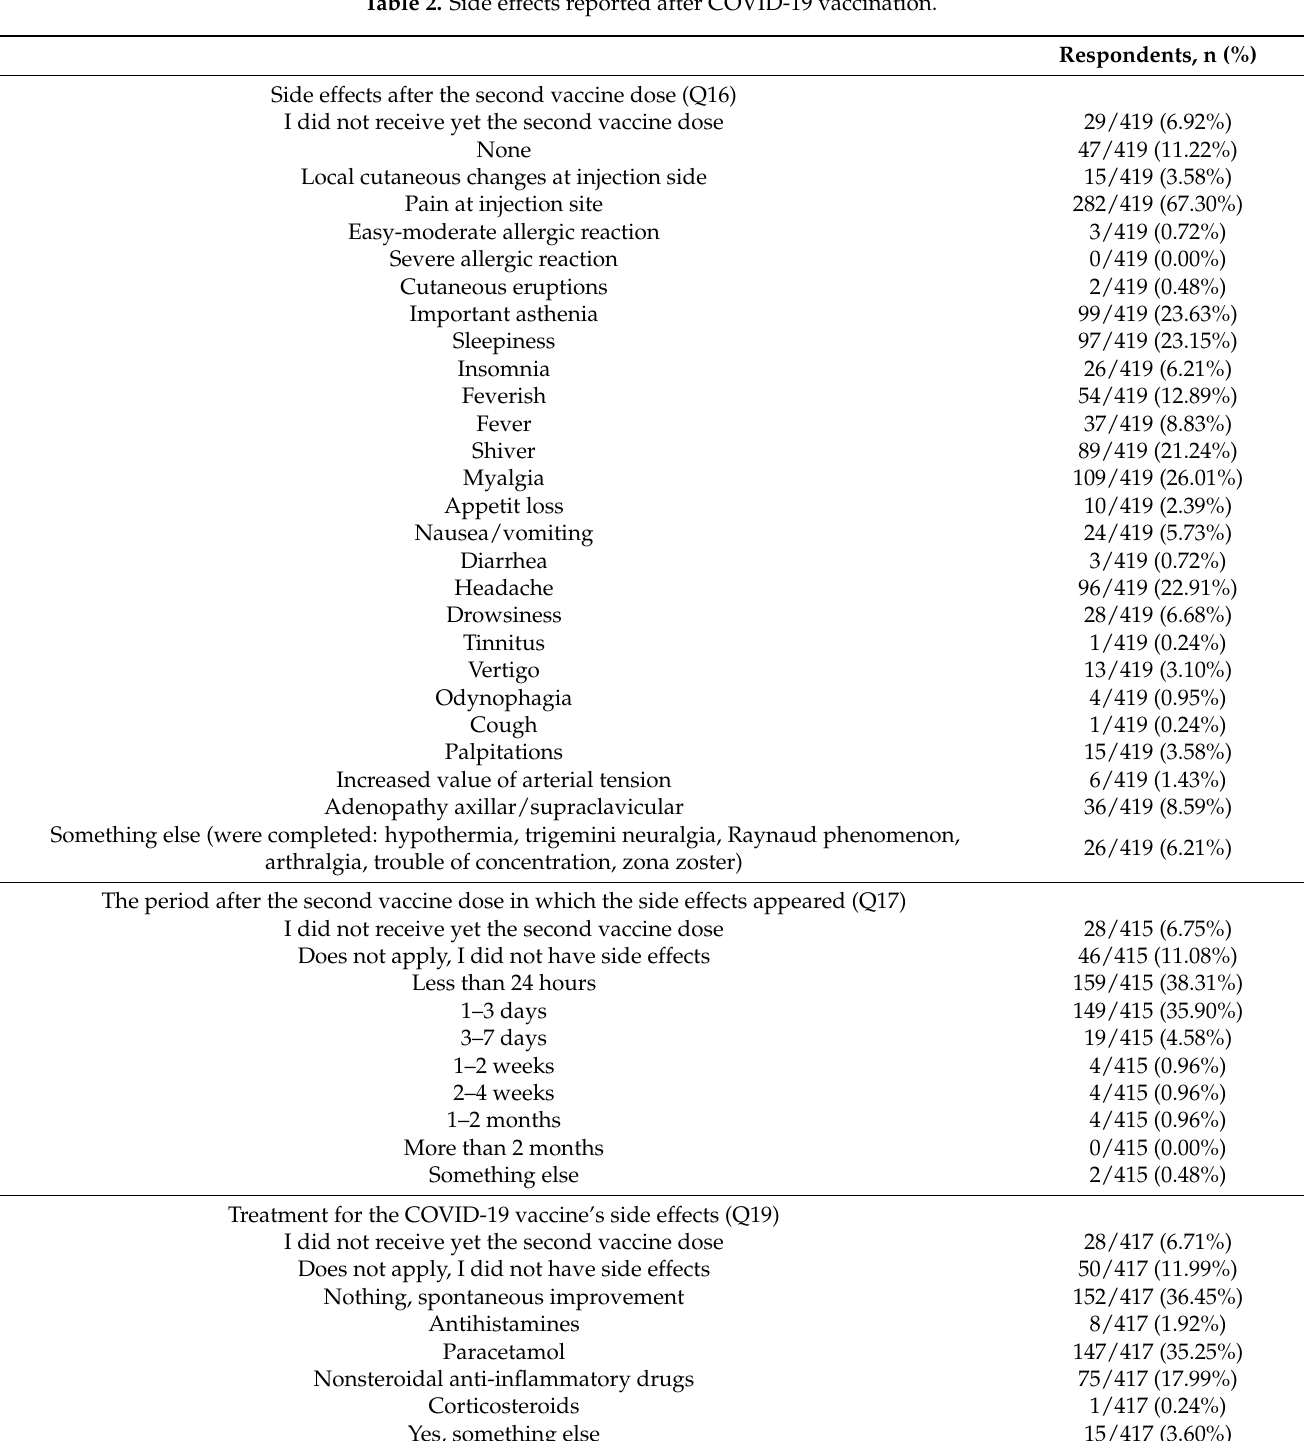
Table 2. Side effects reported after COVID-19